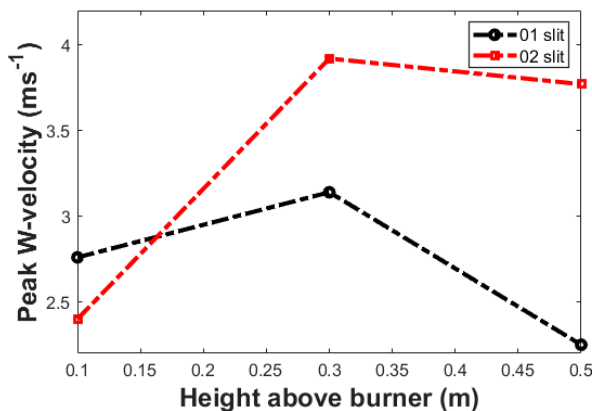
Figure 12. Peak value of W-velocity of the two cases, at all monitoring HABs.